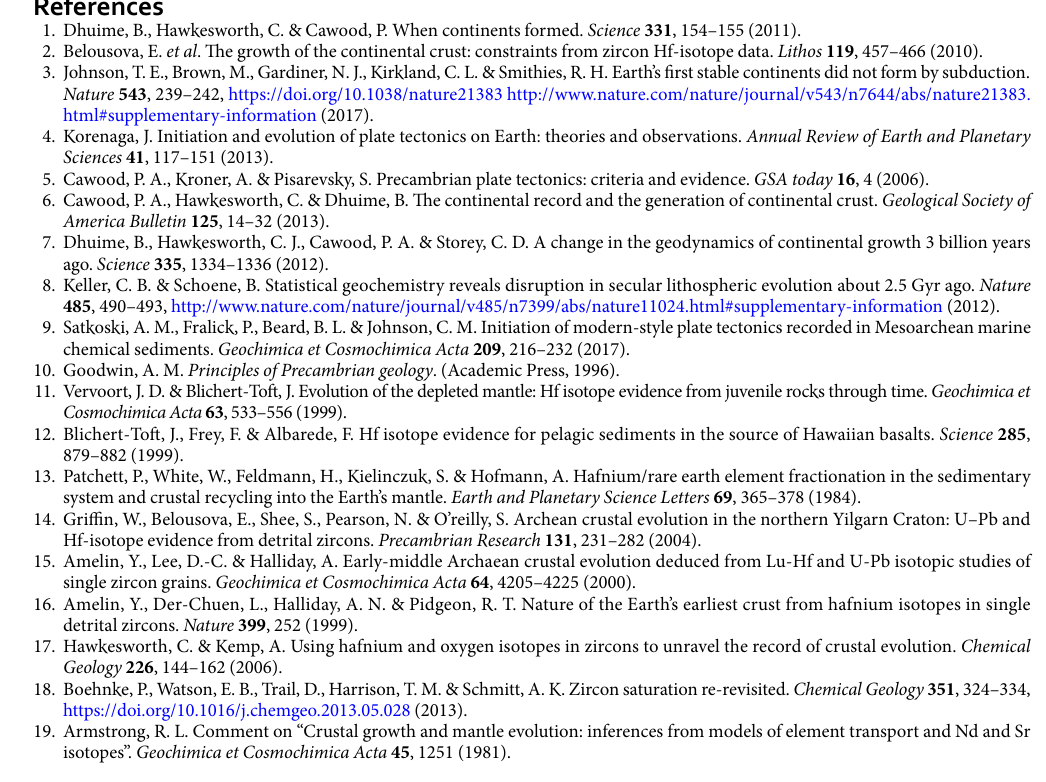
5 Scientific REPORTS | (2018) 8:922 | DOI:10.1038/s41598-018-19397-9